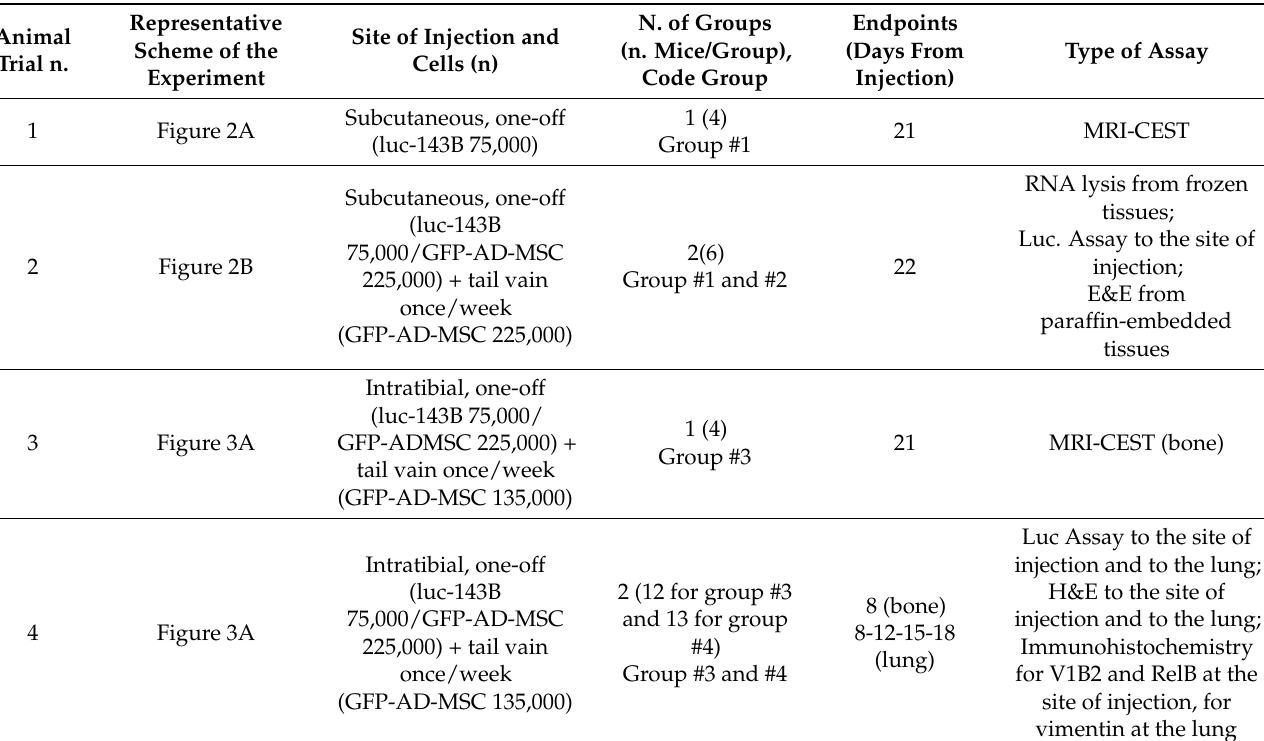
Table 2. List of xenograft experiments.